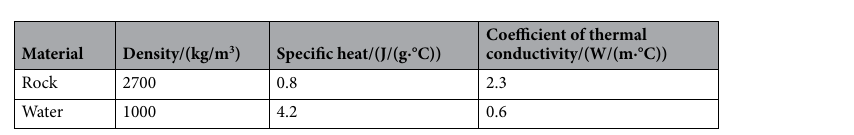
Table 1. Thermophysical parameters of the rock and